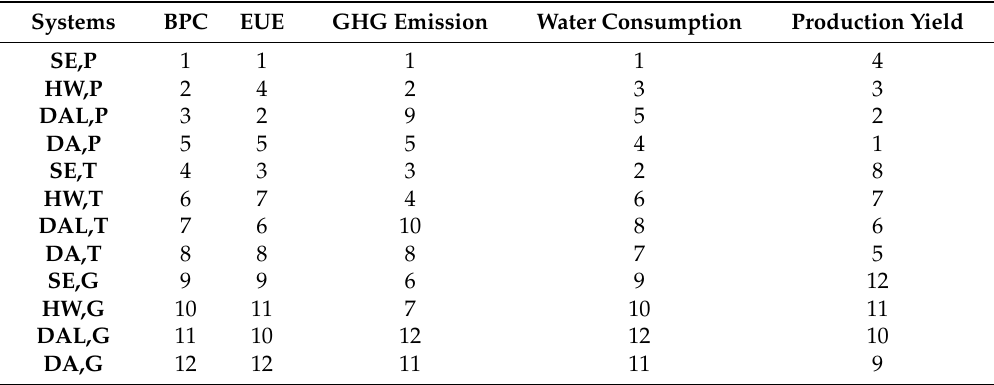
Table 5. Rank order of bioethanol systems based on sustainability indicators.